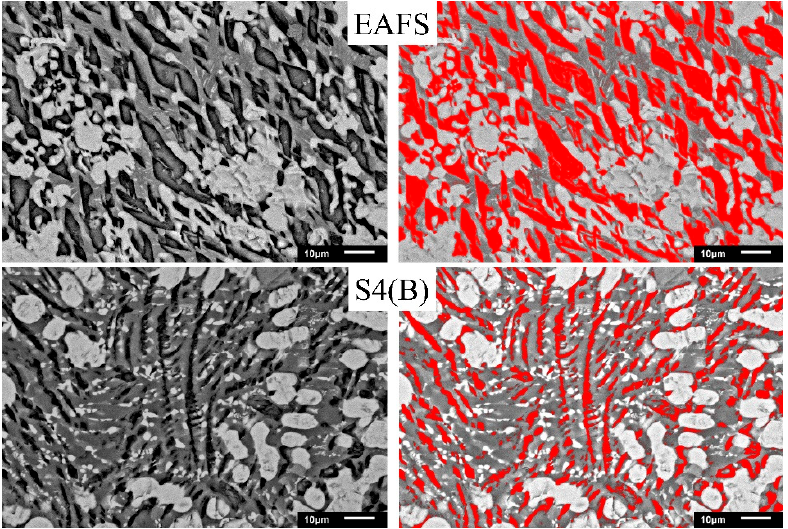
Figure 5. C 2 S phase analysis of EAFS and S4 (B).